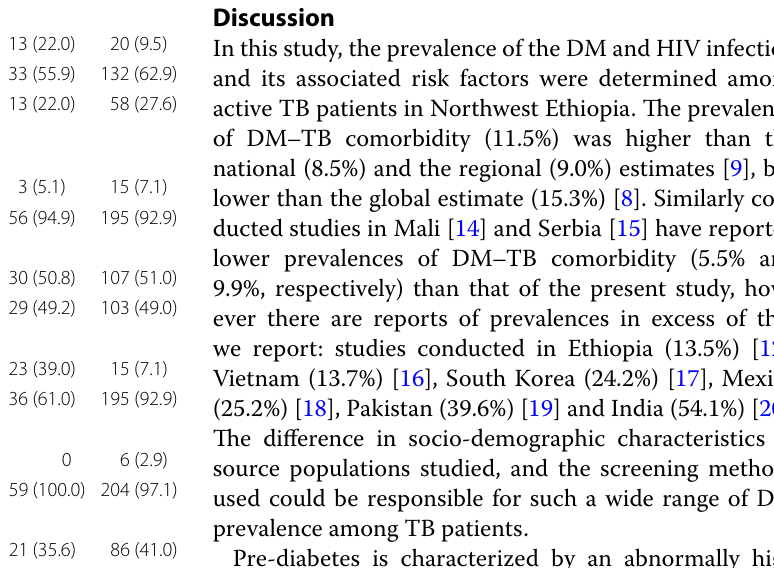
BMI body mass index, EPTB extra-pulmonary TB, DM diabetes mellitus, TB tuberculosis, DMTB DM among tuberculosis, NDMTB negative-DM among TB patients, HIV/TB human immunodeficiency virus infection among TB, NHIV/TB negative HIV infection among TB patients